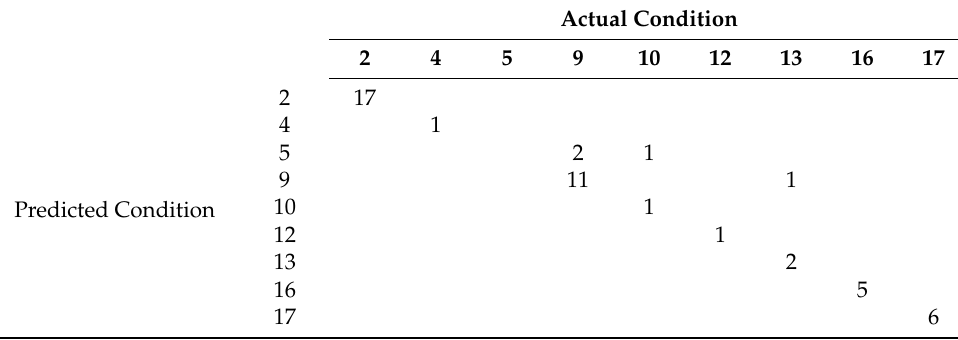
Table 4. Confusion matrix for the real signals